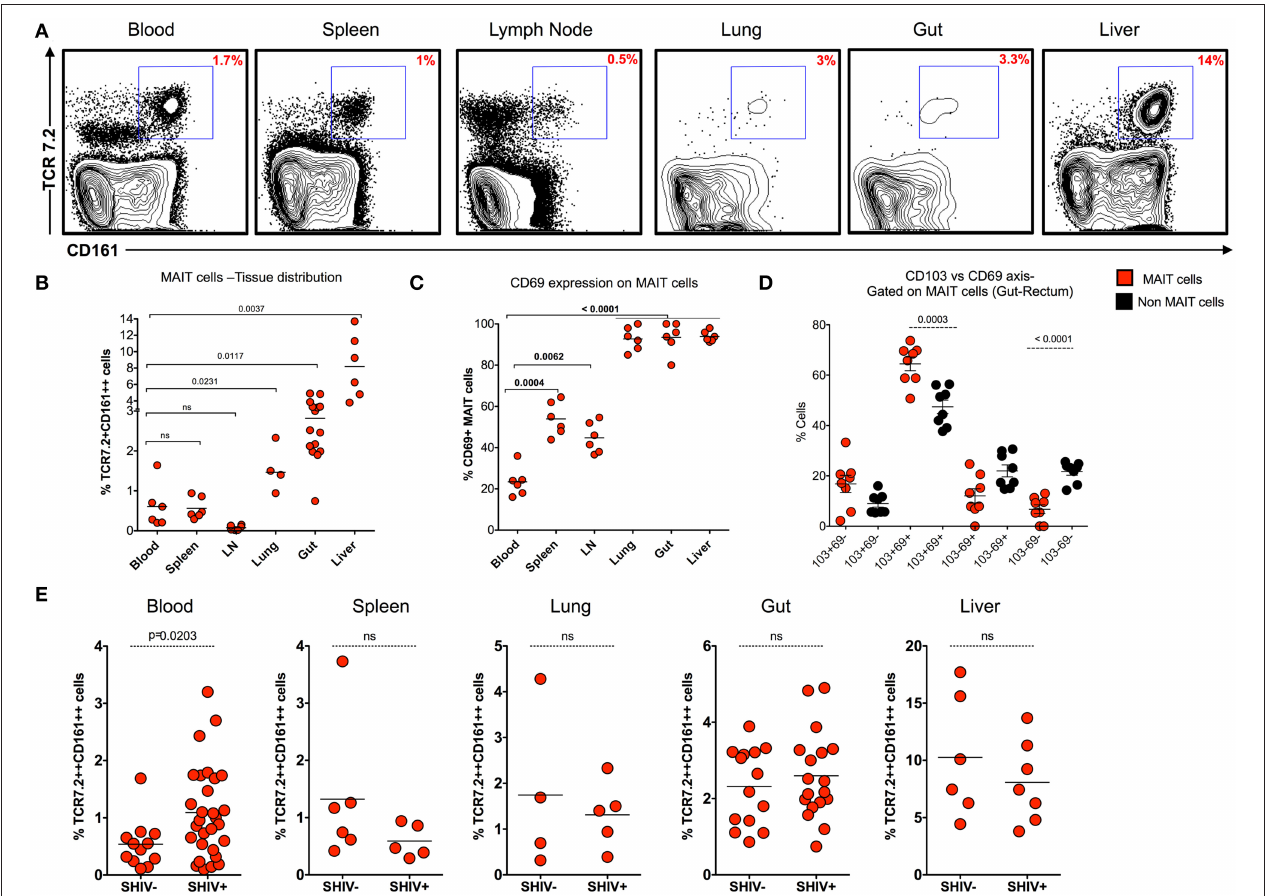
FIGURE 4 | MAIT cells are abundant in non-lymphoid tissues during chronic SHIV infection. (A) Representative flow plots showing the expression of MAIT cells across different tissues post-SHIV infection. (B) Data showing the cumulative frequency of MAIT across all tissues. The liver shows the highest frequency of MAIT cells than any other tissue compartment. (C) Frequency of CD69 + MAIT cells post-SHIV infection. Non-lymphoid tissues express higher levels of CD69 marker than blood and secondary lymphoid tissues. (D) Frequency of rectal MAIT cells in CD103 and CD69 axis; data shown for SHIV-infected animals ( n = 8). MAIT cells co-express higher levels of CD103 and CD69 than non-MAIT cells. (E) Data showing the frequency of MAIT cells between SHIV-naïve and chronically SHIV-infected animals in different compartments (blood, spleen, lung, rectum, and liver). No difference in tissue MAIT cells before and after SHIV